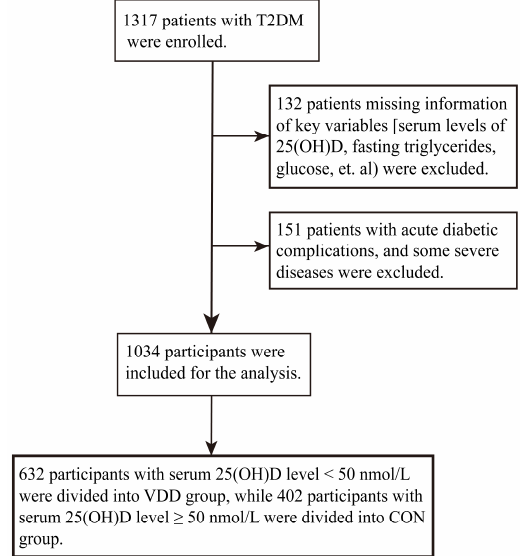
Figure 1. Flowchart of the participants included in the present study.